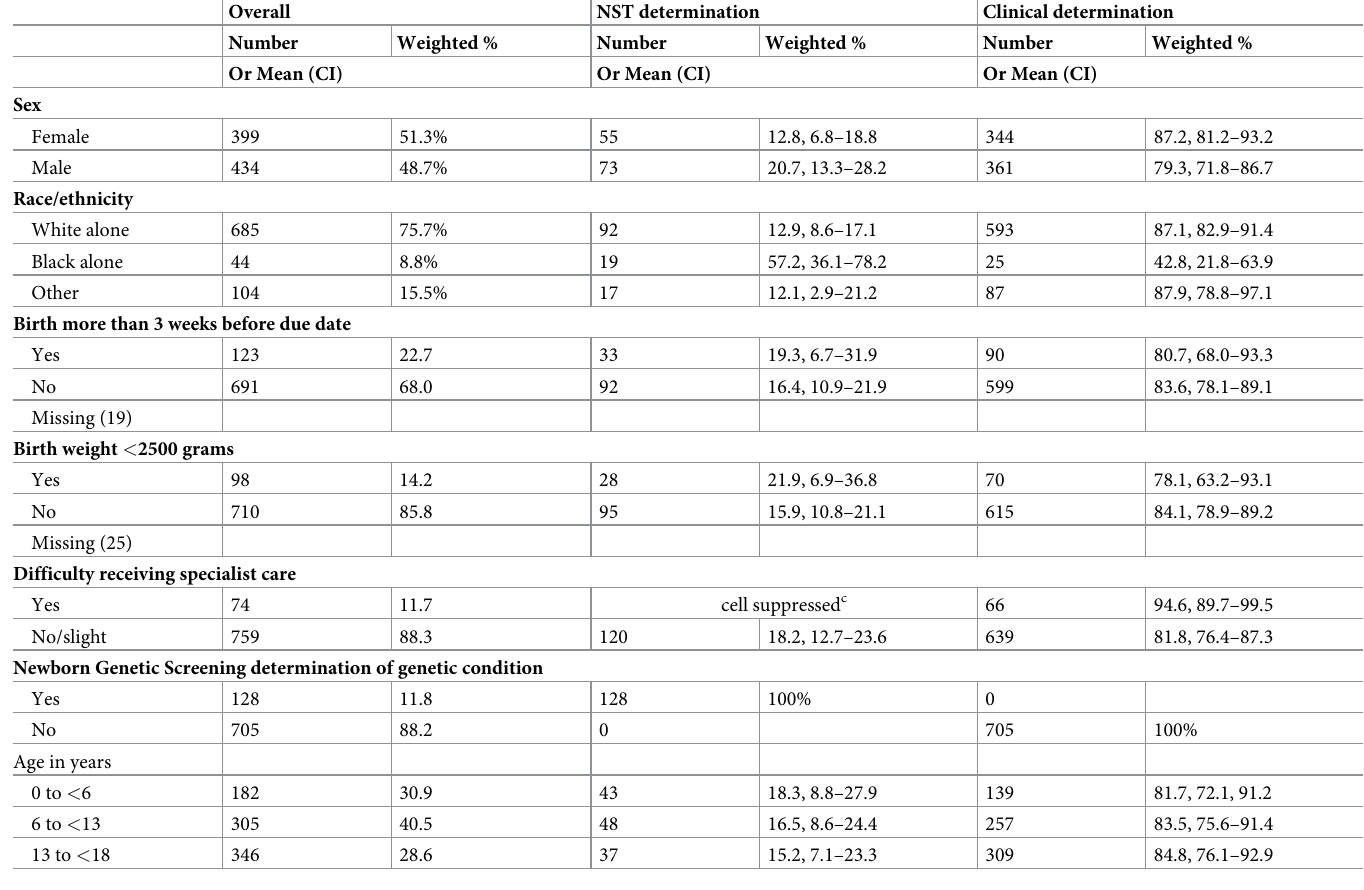
Table 1. Sample characteristics of children with genetic disease/condition, NSCH, a 2020 (n =